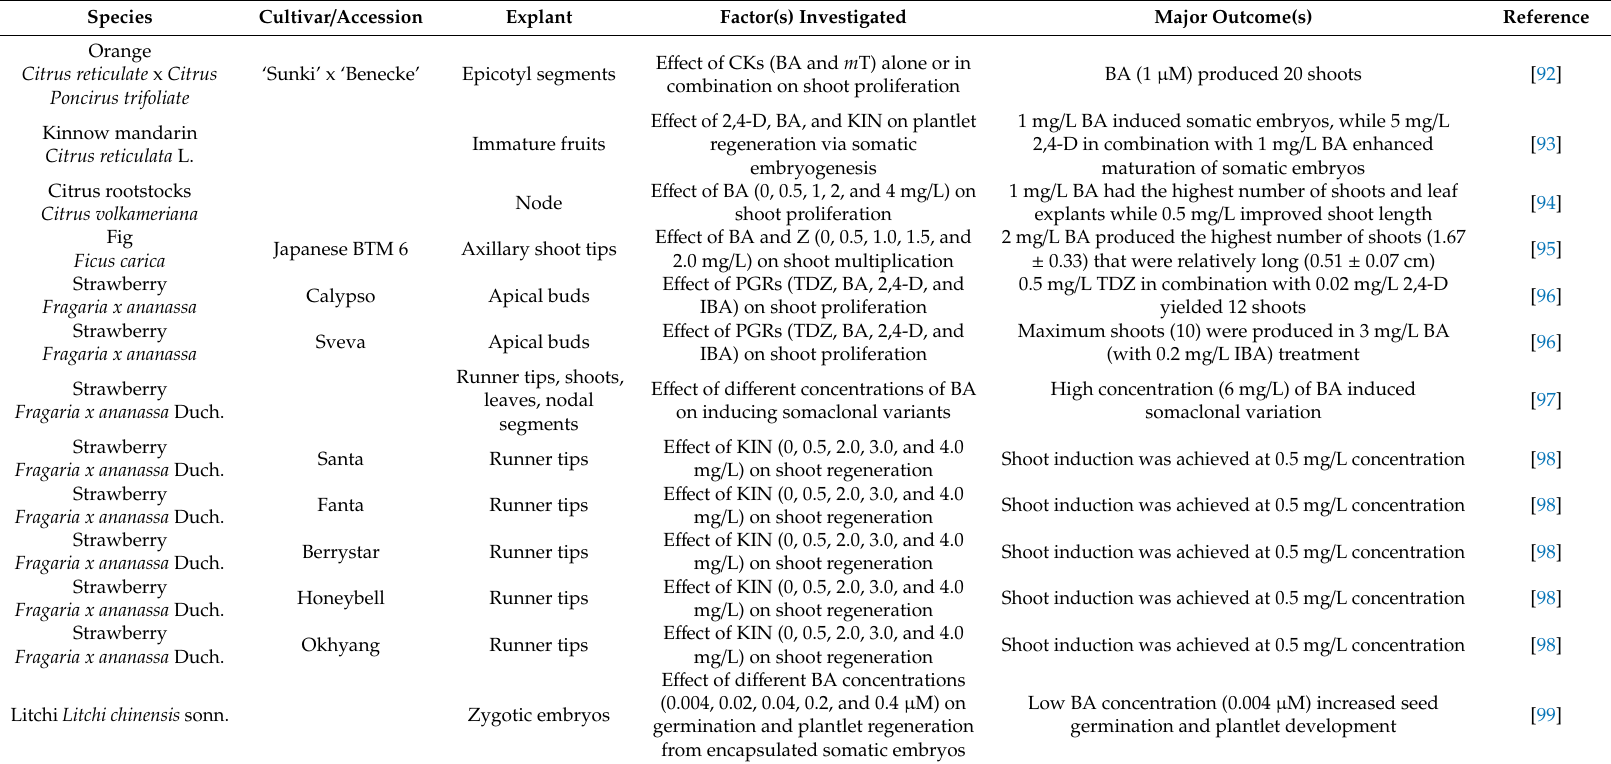
High concentration (6 mg / L) of BA induced somaclonal variation Shoot induction was achieved at 0.5 mg / L concentration [98] E ff ect of KIN (0, 0.5, 2.0, 3.0, and 4.0 mg / L) on shoot regeneration Low BA concentration (0.004 µ M) increased seed germination and plantlet development from encapsulated somatic embryos